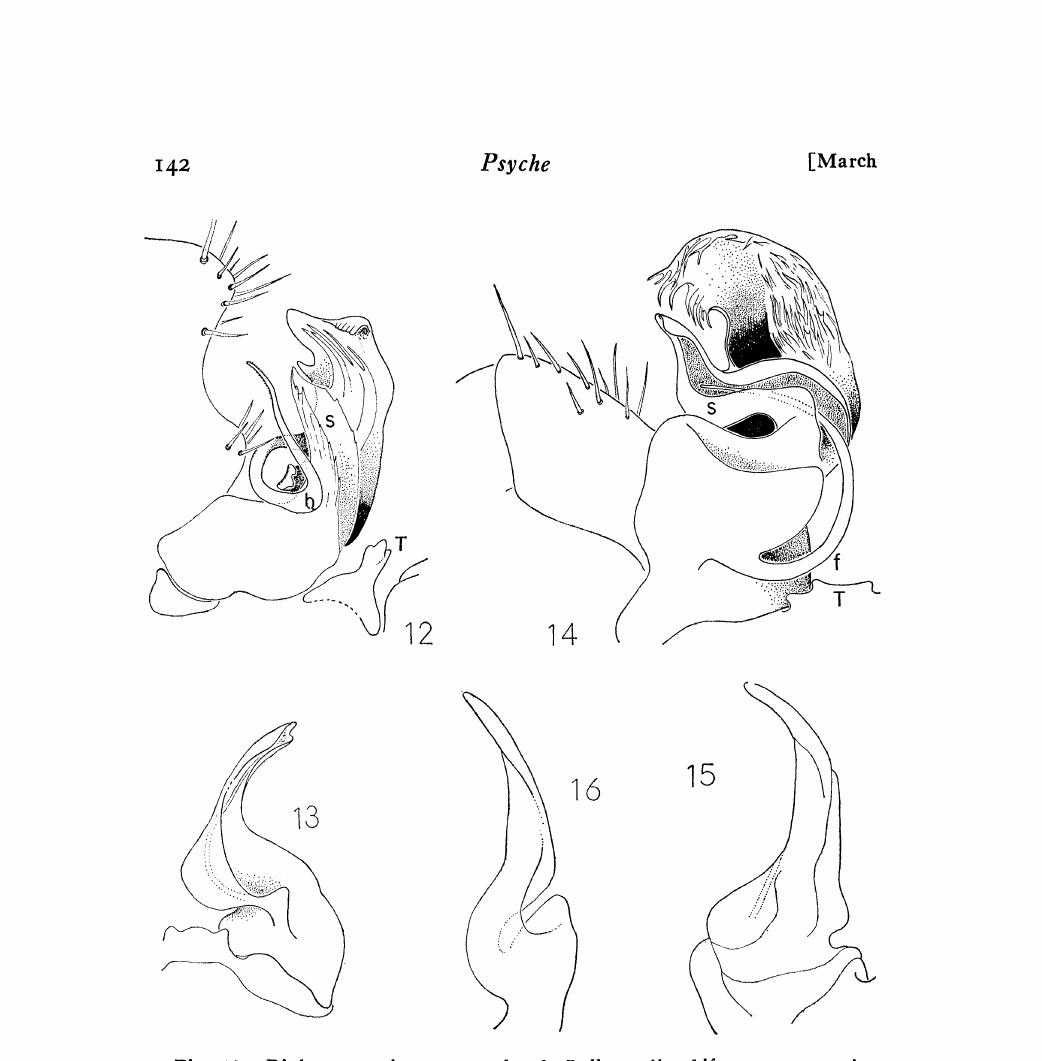
Fig. 12. Right posterior gonopod of Bollmanella bifurcata, posterior view. Figs. 13, 14. B. bella. Eig. 13. Left anterior gonopod, posterior view. Fig. 14. Right posterior gonopod, posterior view. Figs. 15, 16. B. camassia. Fig. 15. Right anterior gonopod, posterior view. Fig. 16. The same, lateral